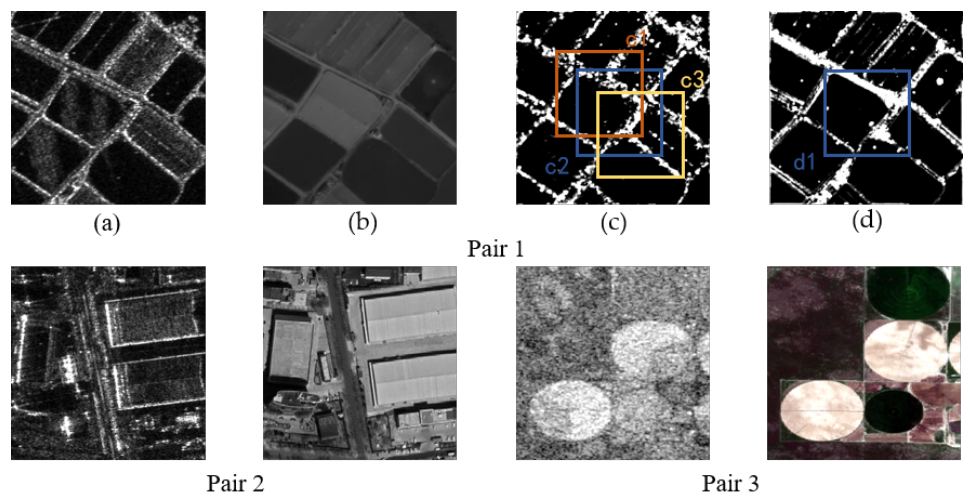
Figure 15. The test image pair for SSIM PC . ( a ) SAR image. ( b ) optical image. ( c ) PC response of SAR image. ( d ) PC response of optical